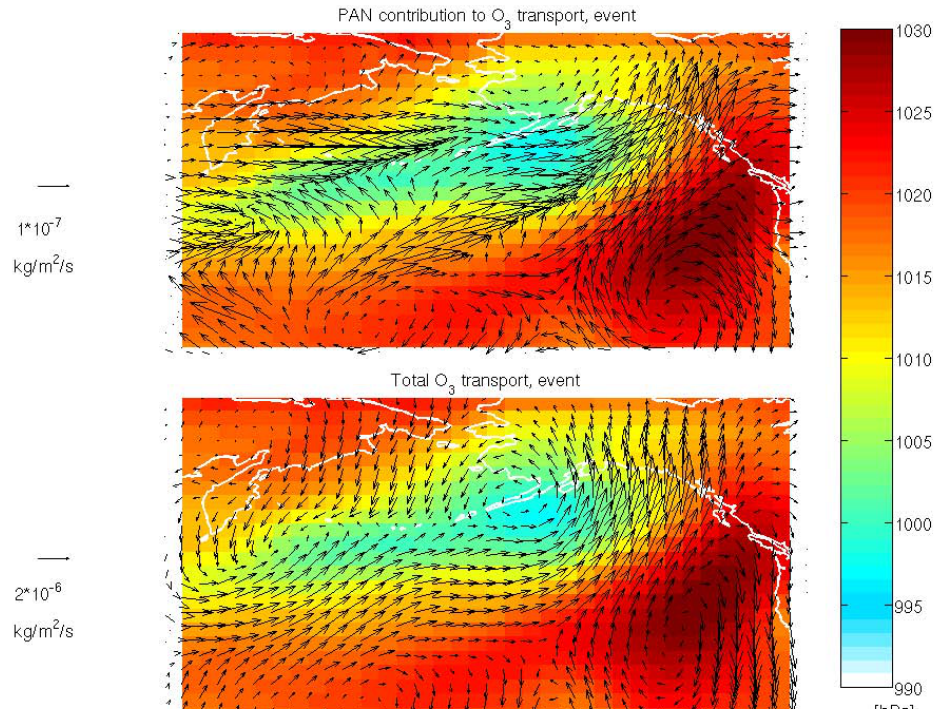
Fig. 13. Simulated ozone fluxes at 2km averaged during the 4 May 2006 event. The two panels show the surface pressure and ozone fluxes on 4 May